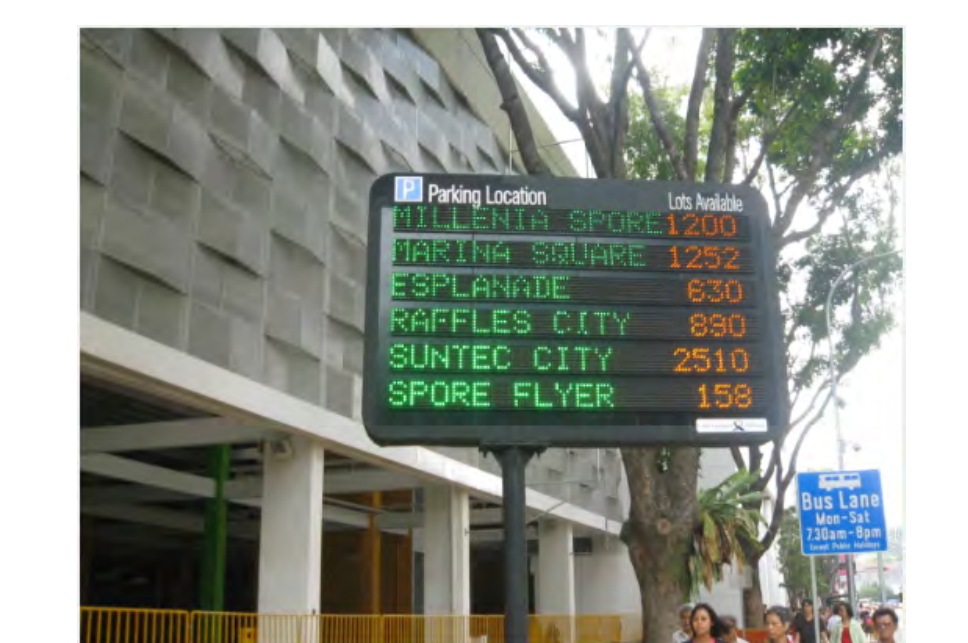
Figure 4. A Parking Guidance System in Singapore (for example). (Harman, 2009)